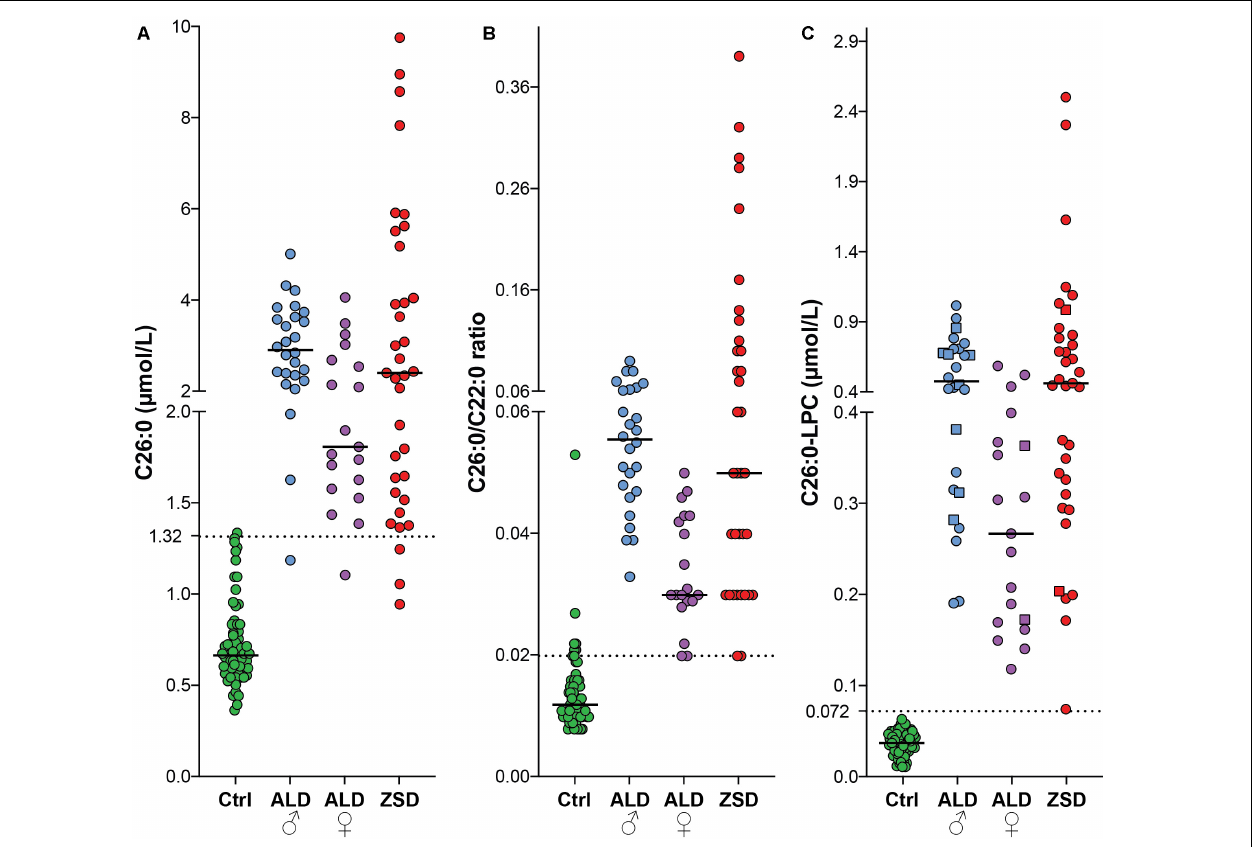
FIGURE 2 | Scatterplots of C26:0 (plasma) (A) , C26:0/C22:0 ratio (plasma) (B) and C26:0-LPC [DBS (squares) and plasma (circles)] (C) from controls (green, n = 67), ALD males (blue, n = 26), ALD females (purple, n = 19) and ZSD patients (red, n = 35). The upper limit of the reference range for C26:0 (1.32 µ mol/L), the C26:0/C22:0 ratio (0.02) and C26:0-LPC in DBS (0.072 µ mol/L) is indicated by the dashed